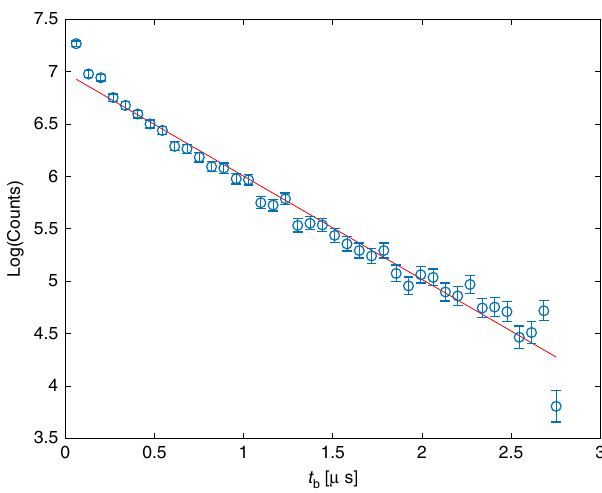
Fig. 5 Lifetime of A 2 state. Lifetime of the quasi-bound HeAr + A 2 state calculated from the positive addition to the TOF of Feshbach Ar ions. Error bars represent statistical errors. The red line represents an exponential fi t.